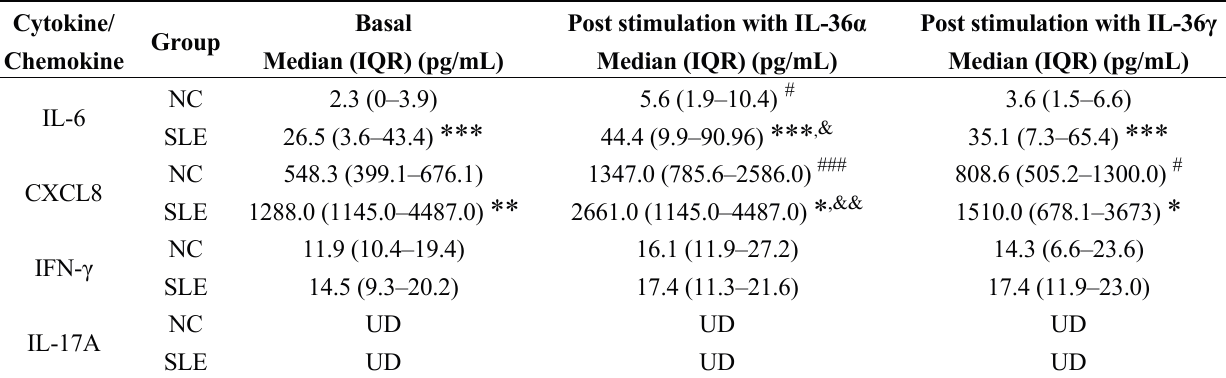
The culture supernatant was derived from PBMC cultured with medium in the presence of human recombinant IL-36 α and IL-36 γ (1 μ g/mL) for 24 h. * p < 0.05, ** p < 0.01 and *** p < 0.001 when compared with